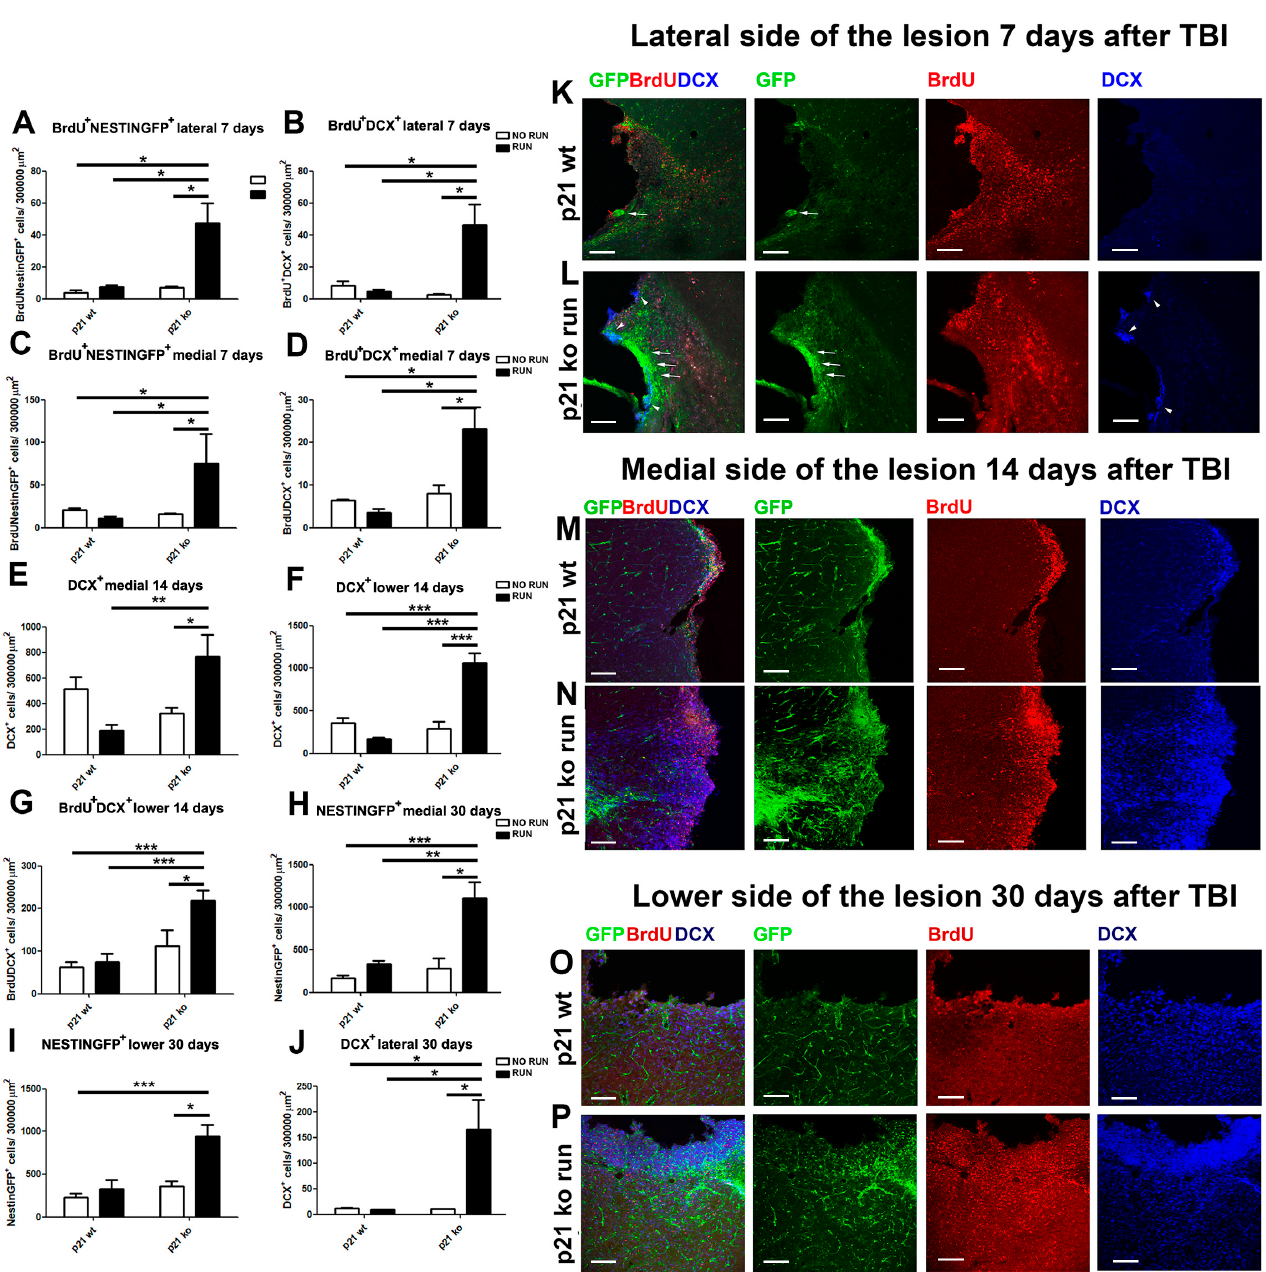
site (BrdU + NestinGFP + : KO RUN TBI vs. WT TBI, p = 0.04, vs. WT RUN TBI, p = 0.027 and vs. KO TBI p = 0.049, Figure 6C; BrdU + DCX + : KO RUN TBI vs. WT TBI, p = 0.026, vs. WT RUN TBI, p = 0.015 and vs. KO TBI p = 0.011, Figure 6D).